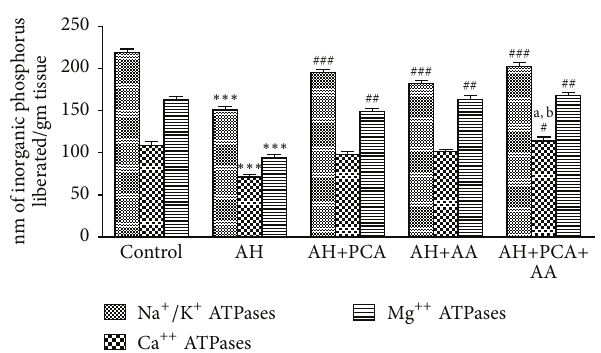
Figure 8: Effect of PCA alone and in combination with AA on Na + /K + ATPase, Ca ++ ATPase, and Mg ++ ATPase in AH-treated rats. Values are expressed as mean ± SEM. Level of significance is considered as ∗ 𝑝 < 0.05 , ∗∗ 𝑝 < 0.01 , and ∗∗∗ 𝑝 < 0.001 compared to control group. # 𝑝 < 0.05 , ## 𝑝 < 0.01 , and ### 𝑝 < 0.001 compared to AH-treated group. a 𝑝 < 0.05 compared to AH+PCA and b 𝑝 < 0.05 compared to AH+AA